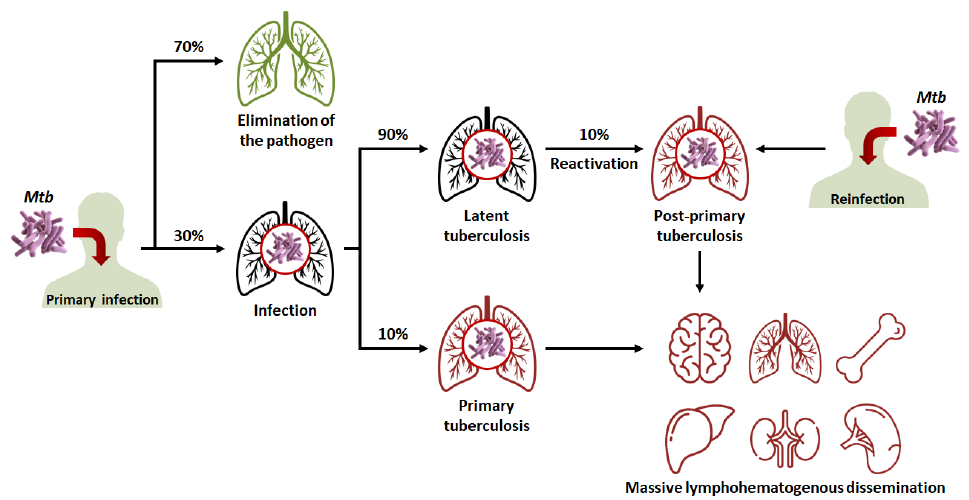
Figure 2. Evolution of the different clinical stages of tuberculosis (TB), from primary infection to miliary TB. Mtb : Mycobacterium tuberculosis . miliary TB. Mtb : Mycobacterium tuberculosis